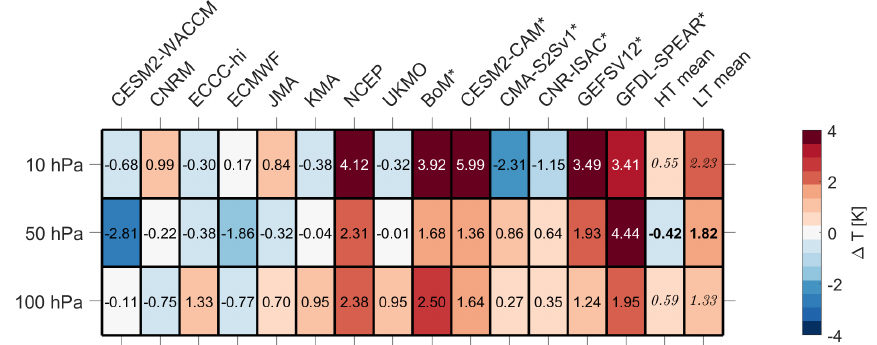
Figure 1. Global- and annual-mean temperature biases at a lead time of 4 weeks. The columns show individual forecast systems, while the rows correspond to different pressure levels. The numerical values displayed are shown in kelvins (K). Asterisks at the end of names denote the systems with low-top models. The last two columns show the high-top (HT) and low-top (LT) composites; the bolded/italicized text in these boxes denotes composite differences that are/are not significant at the 95% level from Student’s t test.